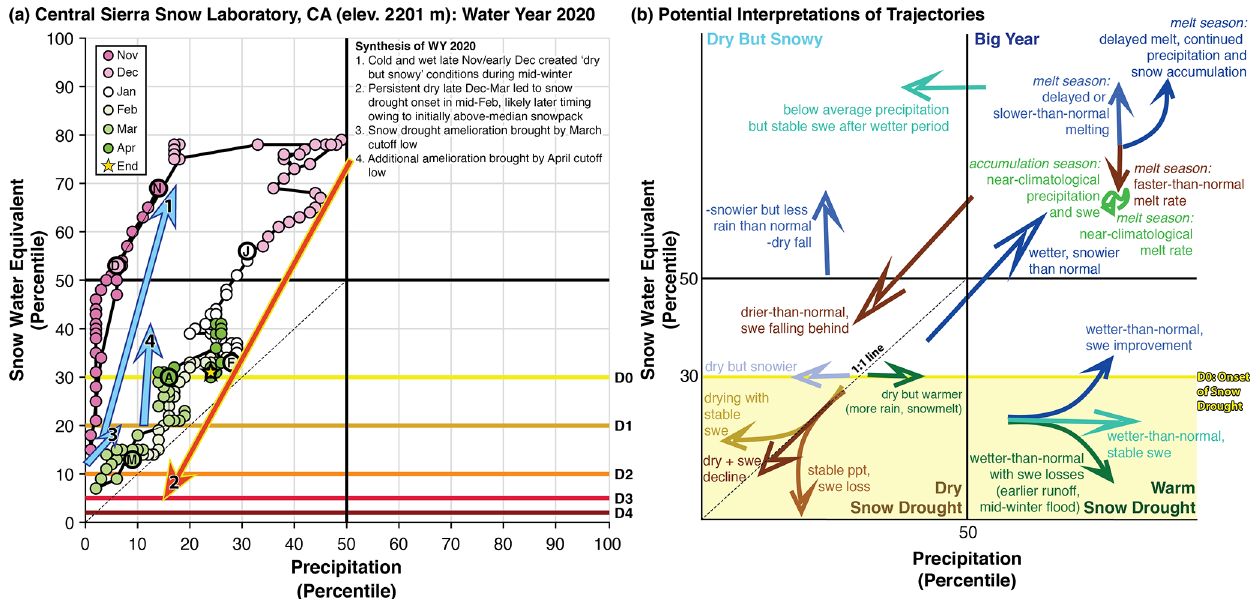
Figure 2. (a) Annotated phase diagram showing 1 November 2019 to 30 April 2020 at the Central Sierra Snow Laboratory (CSS Lab), California. (b) Conceptual phase diagram showing potential physical interpretations of seasonal evolution of various